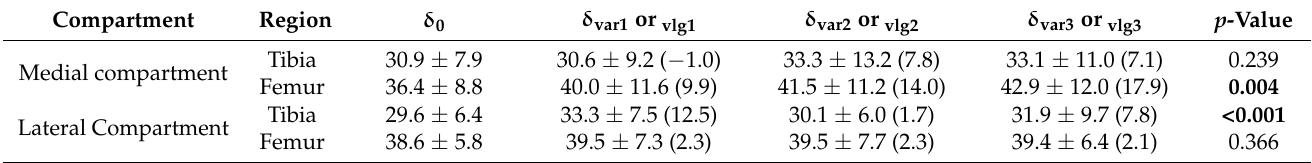
Table 4. Mean absolute T2 relaxation times of femoral and tibial articular cartilage in response to loading. Mean ± standard deviation (ms) (mean percentage change versus δ 0 (%)). Statistical analysis was performed using Friedman’s test with statistically significant findings highlighted in bold type . Please refer to Table 2 for additional details on table organization.